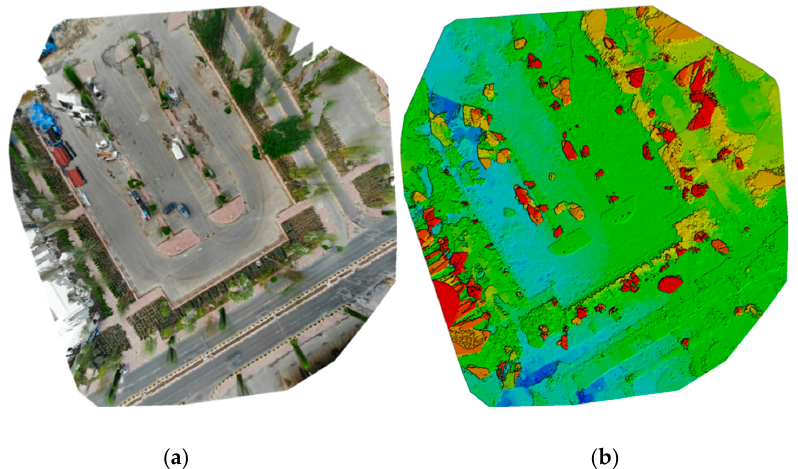
Figure 4. ( a ) Orthomosaic and ( b ) digital surface model (DSM) images of the scene. Table 3. Scenario 1 flight mission parameters.